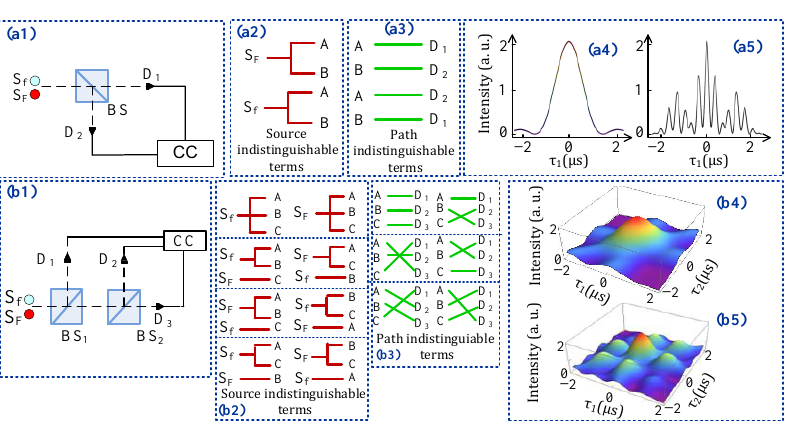
Figure 2. ( a1 , b1 ) Experimental setup to measure second- and third-order temporal intensity–noise correlation function of pseudo-thermal light, respectively. SF and Sf: pseudo-thermal sources. BS: 1:1 non-polarizing beam splitter. D: Detector. ( a2 , b2 ) Source indistinguishable terms for the second- and third-order correlation, respectively. ( a3 , b3 ) Possible path indistinguishable terms for second- and third-order correlation, respectively. ( a4 , a5 ) and ( b4 , b5 ) Calculated second- and third-order temporal correlation function, respectively.